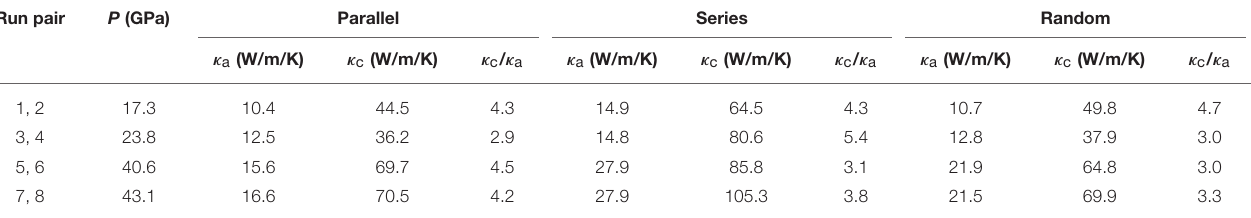
TABLE 2 | Thermal conductivities of hcp iron along each axis. Run pair P (GPa) Parallel Series Random